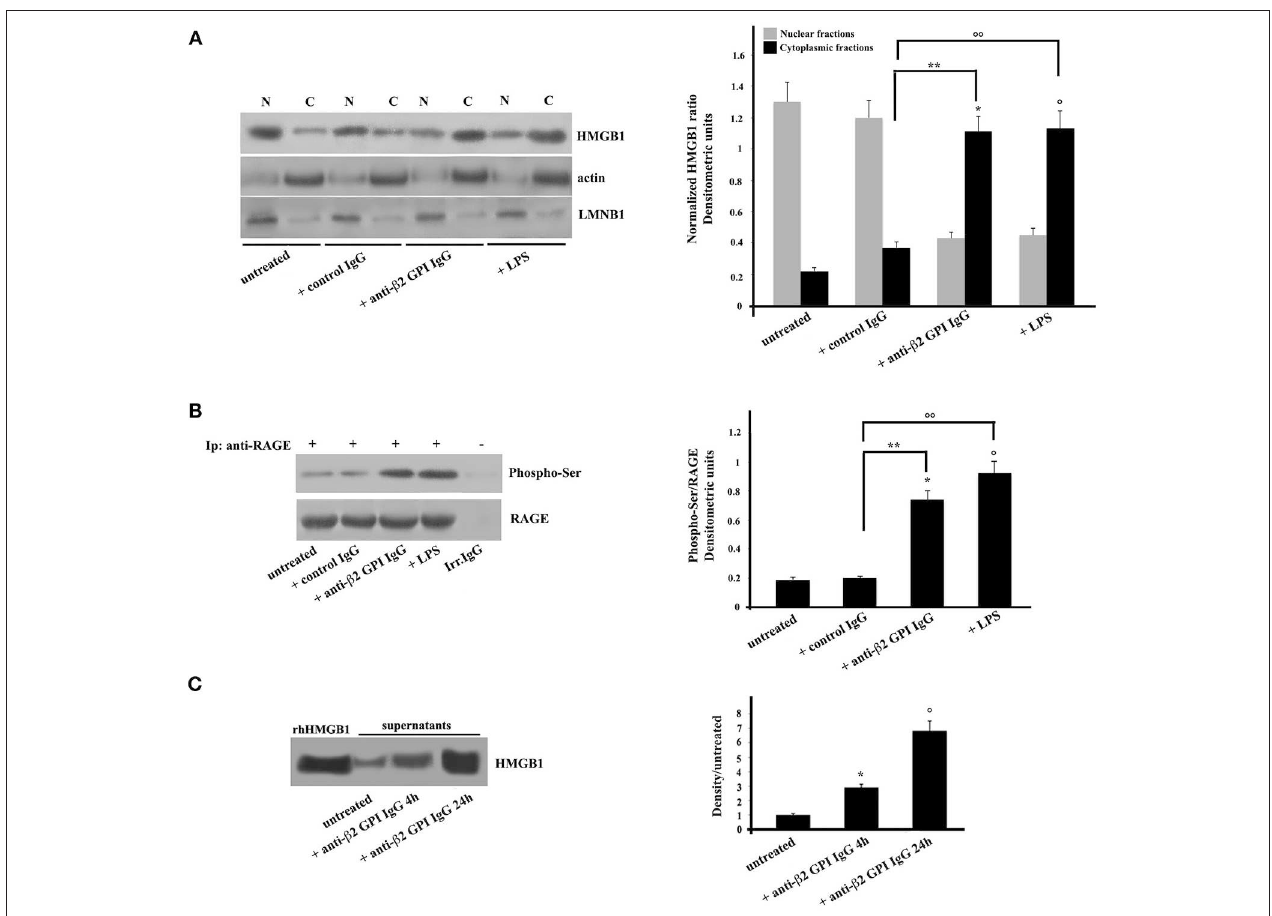
FIGURE 1 | Anti- β 2 -GPI antibodies induce HMGB1 translocation and RAGE phosphorylation in human monocytes. (A) Monocytes from healthy donors, untreated or treated with control human IgG (200 µ g/ml), human affinity-purified anti- β 2 -GPI IgG (200 µ g/ml) or LPS (100ng/ml), for 4h at 37 ◦ C, were subjected to subcellular fractionation. Equal amounts of nuclear (N) or cytosolic (C) extracts were analyzed by immunoblotting using rabbit anti-HMGB1 polyclonal Ab. Lamin B1 (LMNB1) served as nuclear contamination marker and actin as cytoplasmic contamination marker. HMGB1 loading within each compartment was also normalized with Lamin B1 and actin, respectively. As a control, mouse anti-actin monoclonal antibodies and anti-LMNB1 mAb were used. Right panel, densitometric HMGB1 levels are shown. Results represent the mean ± SD from 3 independent experiments. * p + anti- β 2 − GPI IgG < 0.001 vs. untreated, ◦ p + LPS < 0.001 vs. untreated, ** p + anti- β 2 − GPI IgG < 0.001 vs. + control IgG, ◦◦ p + LPS < 0.001 vs. + control IgG. (B) Human monocytes from healthy donors, untreated or treated with control human serum IgG (200 µ g/ml), with human affinity-purified anti- β 2 -GPI IgG (200 µ g/ml) or LPS (100ng/ml), for 4h at 37 ◦ C, were immunoprecipitated with goat anti-RAGE polyclonal Ab. Immunoprecipitates were analyzed using mouse anti-Phospho-Ser monoclonal antibody. Immunoprecipitation was checked by mouse anti-RAGE mAb. Right panel, densitometric phospho-Ser /RAGE ratios are shown. Results represent the mean ± SD from 3 independent experiments. * p + anti- β 2 -GPI IgG < 0.001 vs. untreated, ◦ p + LPS < 0.001 vs. untreated, ** p + anti- β 2 -GPI IgG < 0.001 vs. + control IgG, ◦◦ p + LPS < 0.001 vs. + control IgG. (C) Western blot analysis of monocyte supernatants for HMGB1. The supernatants of untreated and cells treated for the indicated times with human affinity-purified anti- β 2 -GPI and HMGB1 standard (rhHMGB1) were run under reducing conditions on the gel (12% SDS-PAGE) and transferred to nitrocellulose. Filters were stained with rabbit anti-HMGB1 polyclonal Ab. Right panel, density/untreated is shown. Results represent the mean ± SD from 3 independent experiments. * p + anti- β 2 -GPI IgG 4h < 0.001 vs. untreated, ◦ p + anti- β 2 -GPI IgG 24h < 0.001 vs.